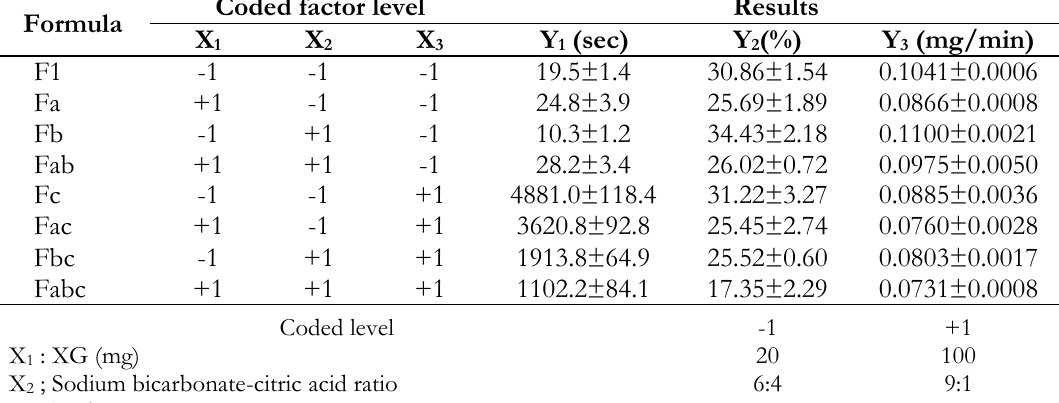
Table I. A 2 3 factorial design models and the results of floating lag time and drug release